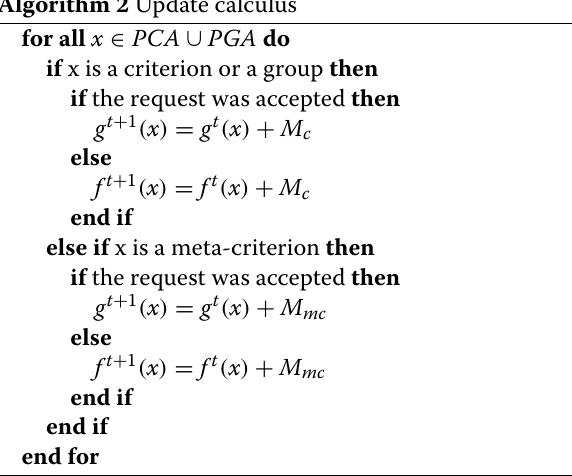
Algorithm 2 Update calculus